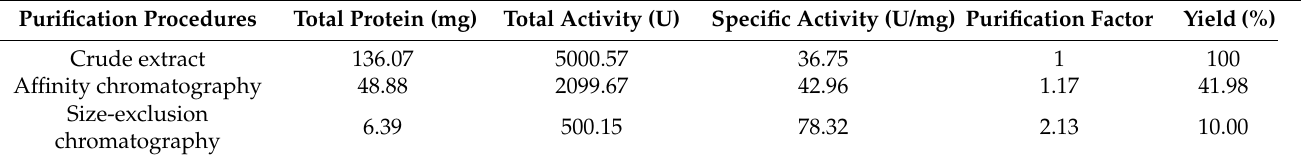
Table A2. Purification yields of recombinant